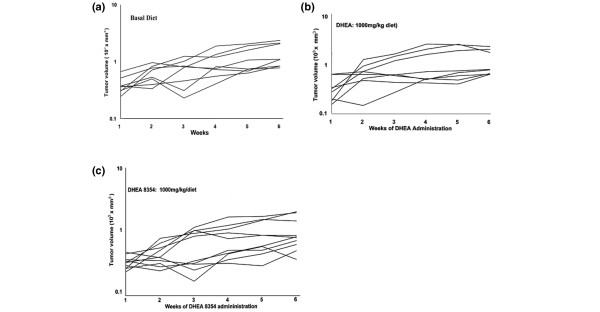
DHEA and DHEA8354 suppress the growth of mammary tumors. (a) Growth curves of mammary tumors in control animals. (b, c) Growth curves of mammary tumors in animals treated with dehydroepiandrosterone (DHEA) (b) or DHEA 8354 (c) (1,000 mg/kg in diet). In 50% of DHEA-treated tumors a net decrease in growth potential over control was observed, whereas with DHEA 8354 some animals showed a decrease in growth potential. Each curve represents an individual tumor.